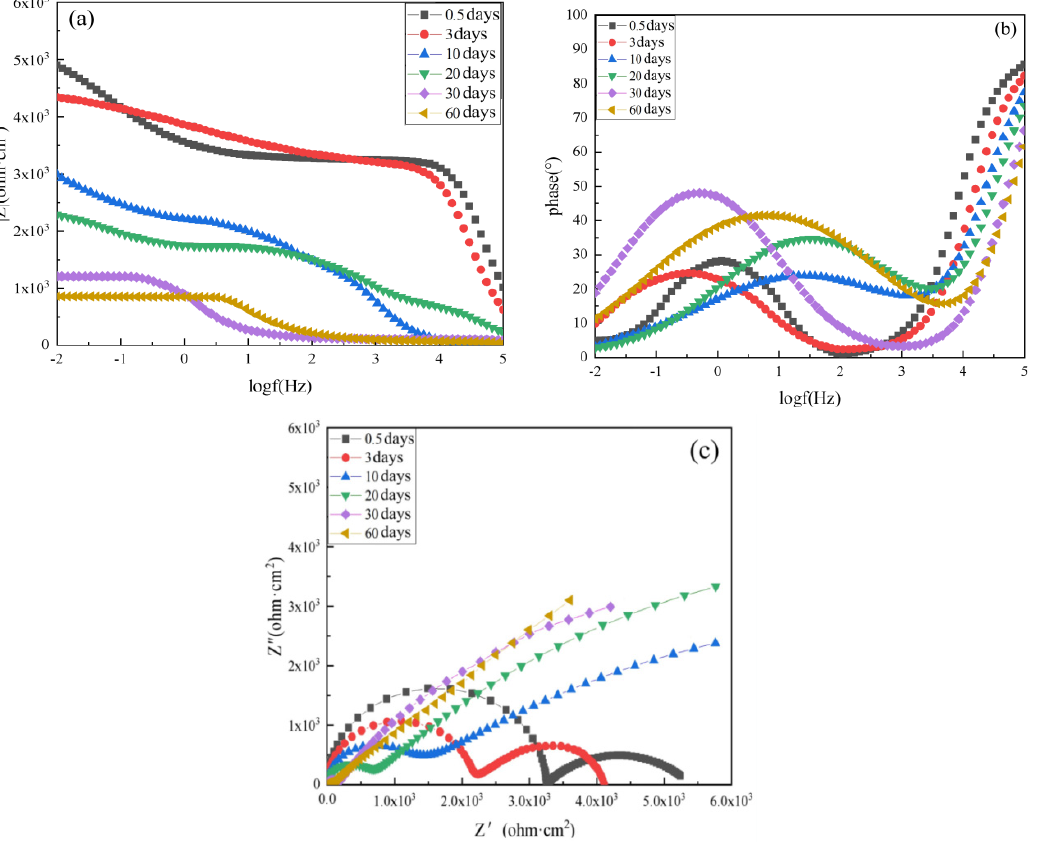
Figure 9. EIS results of pure epoxy resin coating after UV aging for 100 days and immersion for various lengths of time in 3.5 wt.% NaCl solution: ( a ) Bode diagram, ( b ) phase angle diagram, and ( c ) Nyquist diagram.